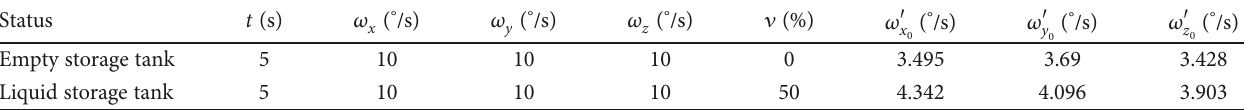
Table 4: Simulation results of the empty storage tank and liquid storage tank.